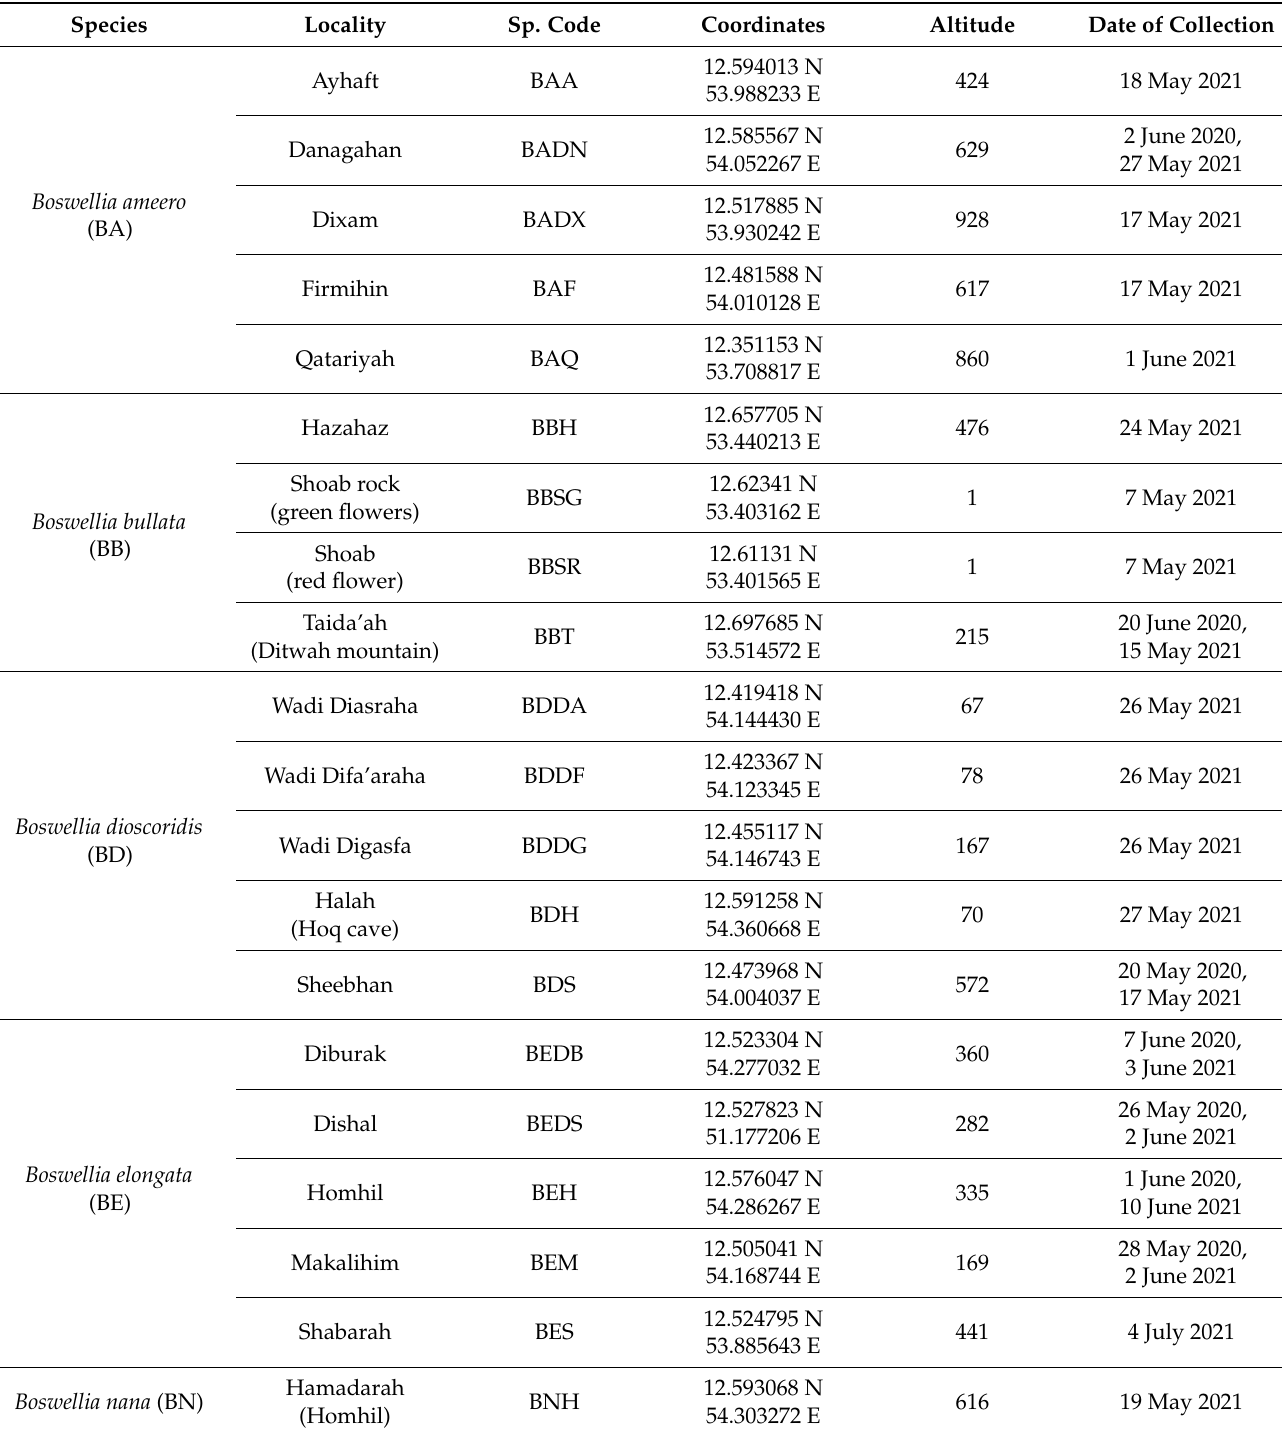
Table 1. List of codes, (sub)species, locality names, coordinates, altitude, and date of collection of the 9 Boswellia taxa from Socotra Island (Yemen) assessed in this study.